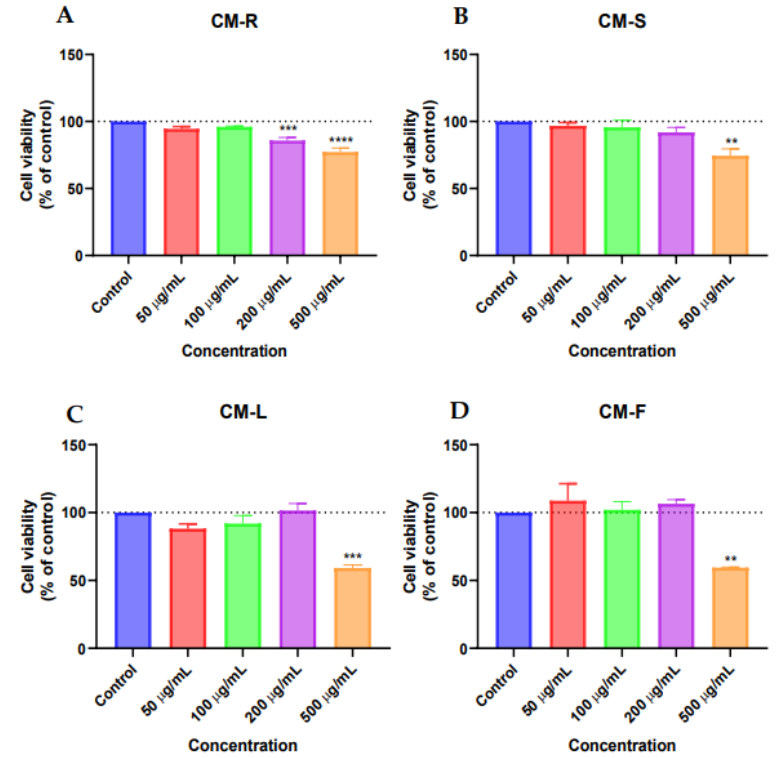
Figure 5. Cytotoxic evaluation of Cladanthus mixtus extracts on PC-3 cells after 48 h of treatment. ( A ): root extract, ( B ): stem extract, ( C ): leaf extract, ( D ): flower extract. Data are given as the mean ± SEM (n = 3), ** statistically significant vs. control (vehicle) at p < 0.01; *** statistically significant vs. control (vehicle) at p < 0.001; **** statistically significant vs. control (vehicle) at p < 0.0001.